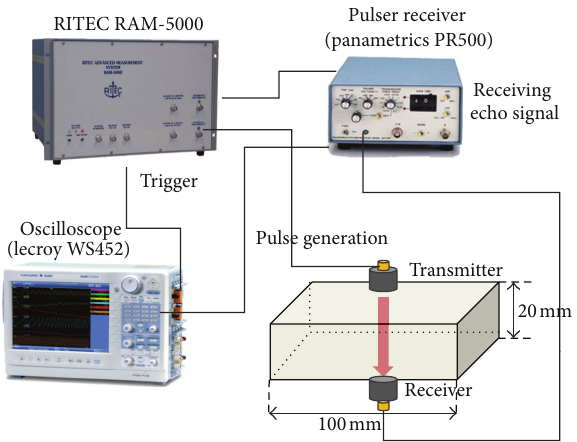
Figure 1: Experimental system to measure the ultrasonic nonlinear parameter.